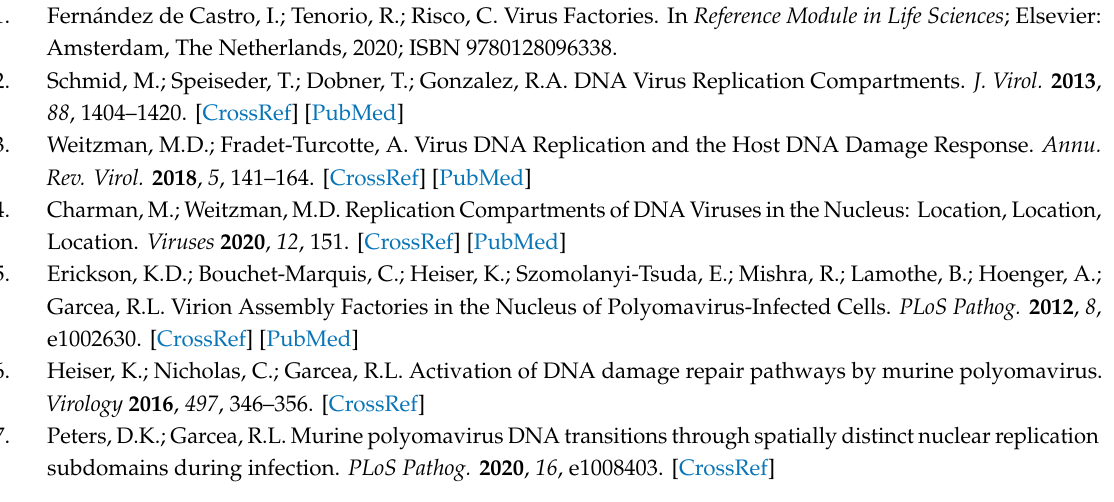
Figure S1: Additional characterization of GFP-RPA32- and GFP-NLS-expressing cell lines; Figure S2: Additional analysis of VRC dynamics during live cell microscopy. Video S1: Movie of uninfected GFP-RPA32-expressing cell from Figure 3. Video S2: Movie of infected GFP-RPA32-expressing cell from Figure 3. Video S3: Movie of WT MuPyV-infected GFP-RPA32-expressing cell from Figure 5. Video S4: Movie of 808A-infected GFP-RPA32-expressing cell from Figure 5. Video S5: Movie of NG18-infected GFP-RPA32-expressing cell from Figure 5. Video S6: Movie of NG59-infected GFP-RPA32-expressing cell from Figure